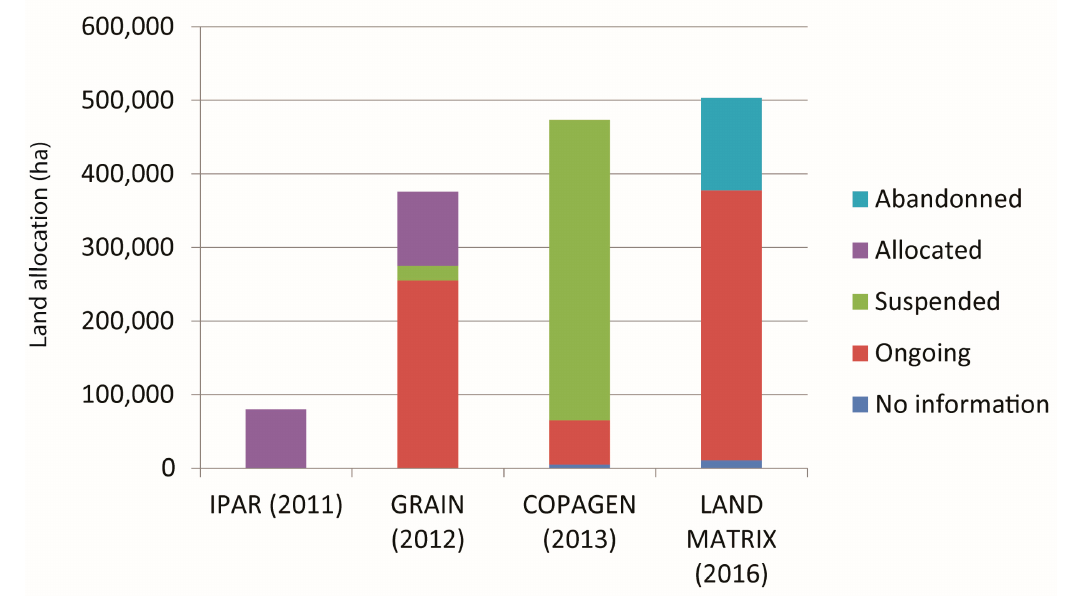
Figure 2. Status of reported land deals from different sources (IPAR: Initiative Prospective Agricole et Rurale; COPAGEN: Coalition pour la Protection du Patrimoine G é n é tique